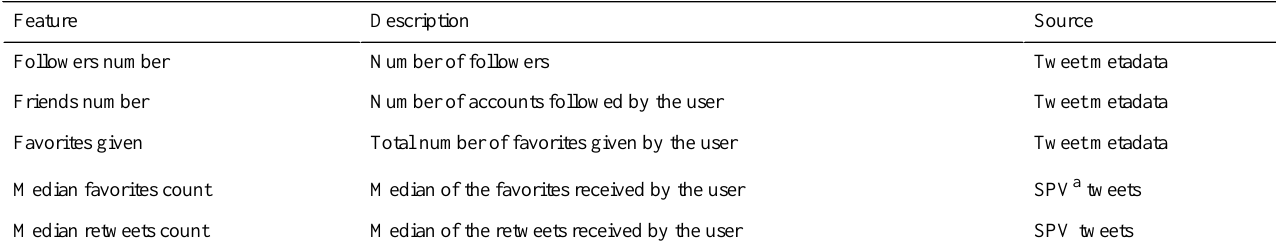
Table 3. Description of relational